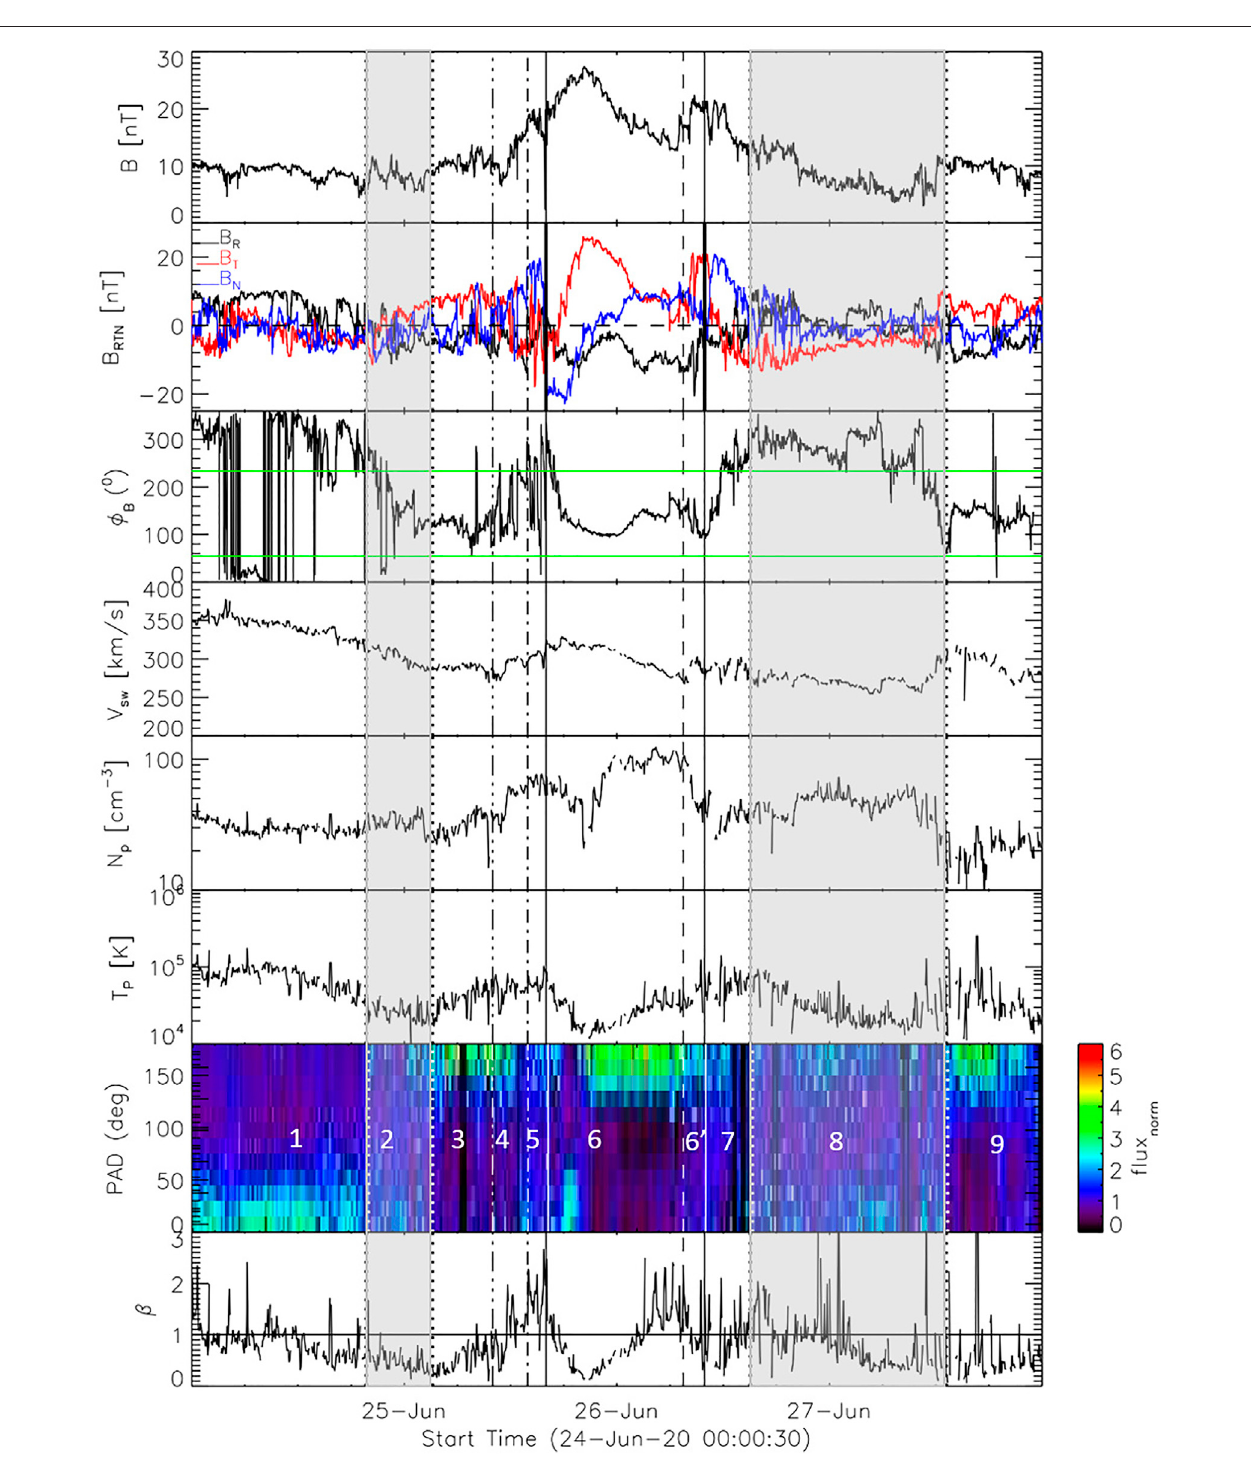
FIGURE 5 | Solar wind magnetised plasma measurements (from top to bottom: B , B RTN , ϕ B , V sw , N p , T p , PAD of normalised suprathermal electron fl ux, plasma- β ) during 24 – 27 June2020.The ϕ B between horizontal green lines correspondtosunward IMF. The solid black lines show t in and t out and the dashed vertical lineindicates t out * . The shaded regions correspond to HCS/HPS crossings. The annotated regions indicate the regions 1 – 9 described in text.